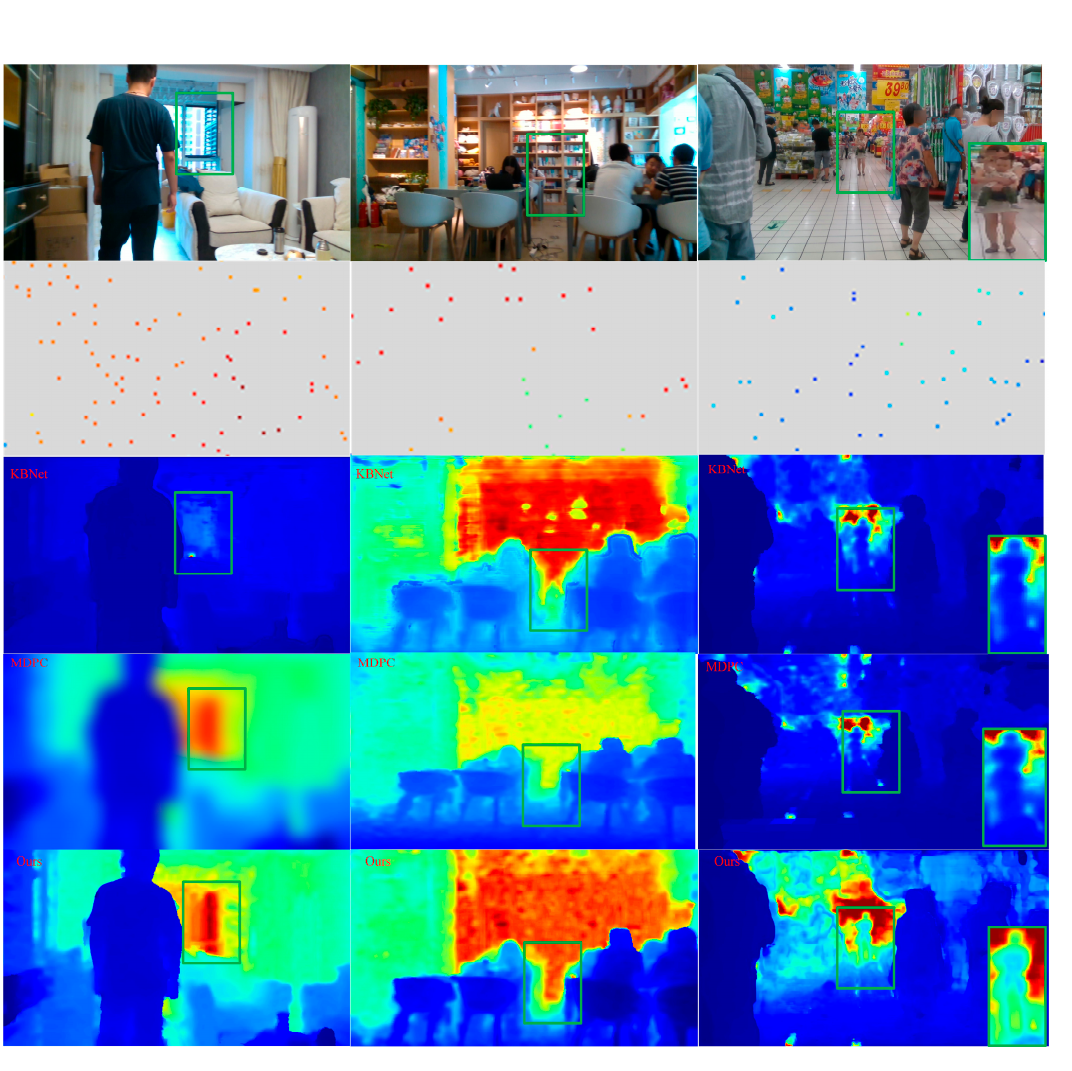
Figure 9. Qualitative results on generalization in real scenes. Head-to-head comparison against [9,32]. Our method is better in generalization ability. Note that the sparse depth images are enlarged for visualization and only the areas highlighted in green are shown.